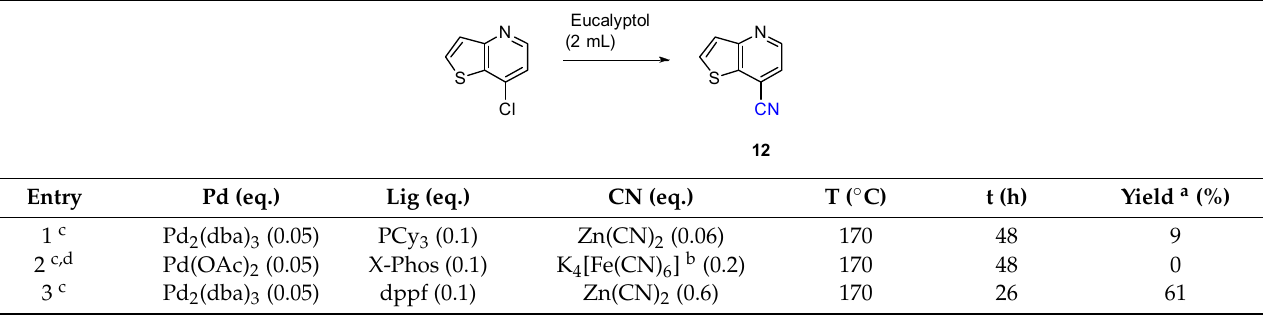
Figure 5. Palladium catalyzed cyanation of 7-bromo-6-phenyl-thieno[2,3- b ]pyrazine. Table 3. Optimization of cyanation. Table 3. Optimization of cyanation.